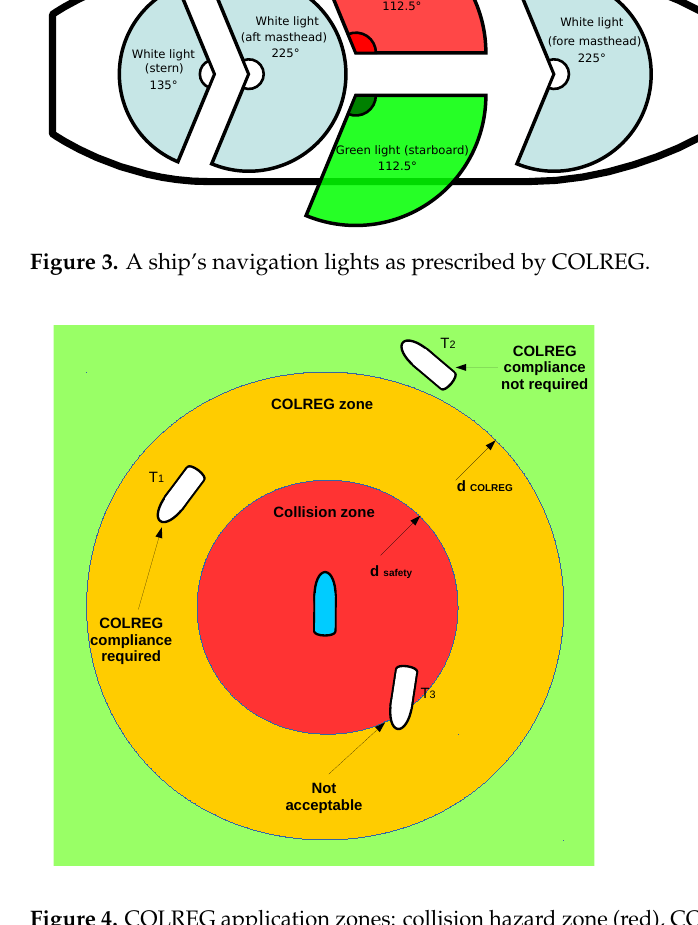
Figure 4. COLREG application zones: collision hazard zone (red), COLREG application zone (yellow) and free navigation zone